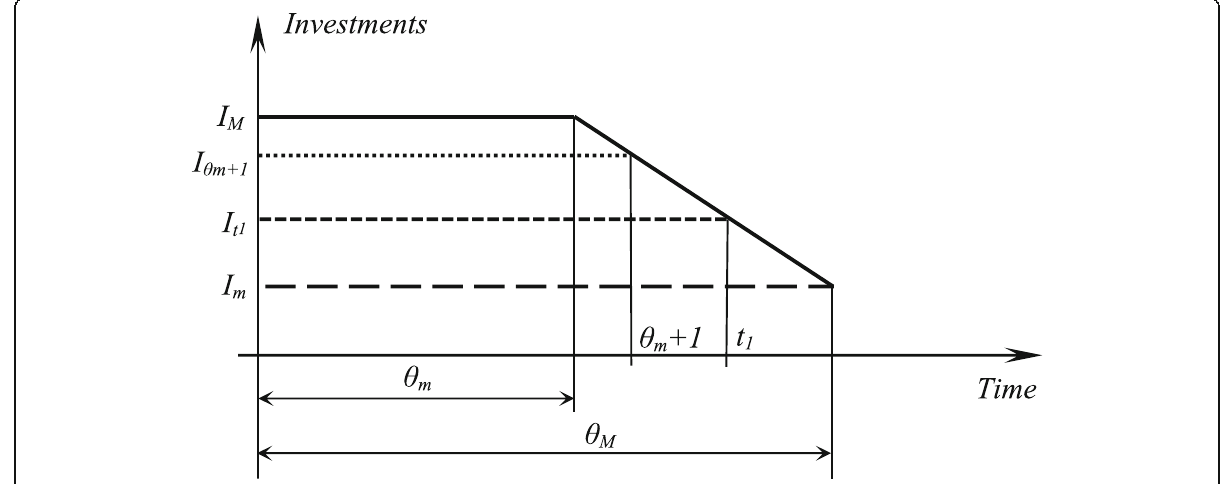
Fig. 4 The amount of annual investment as a rectilinear function of the completion